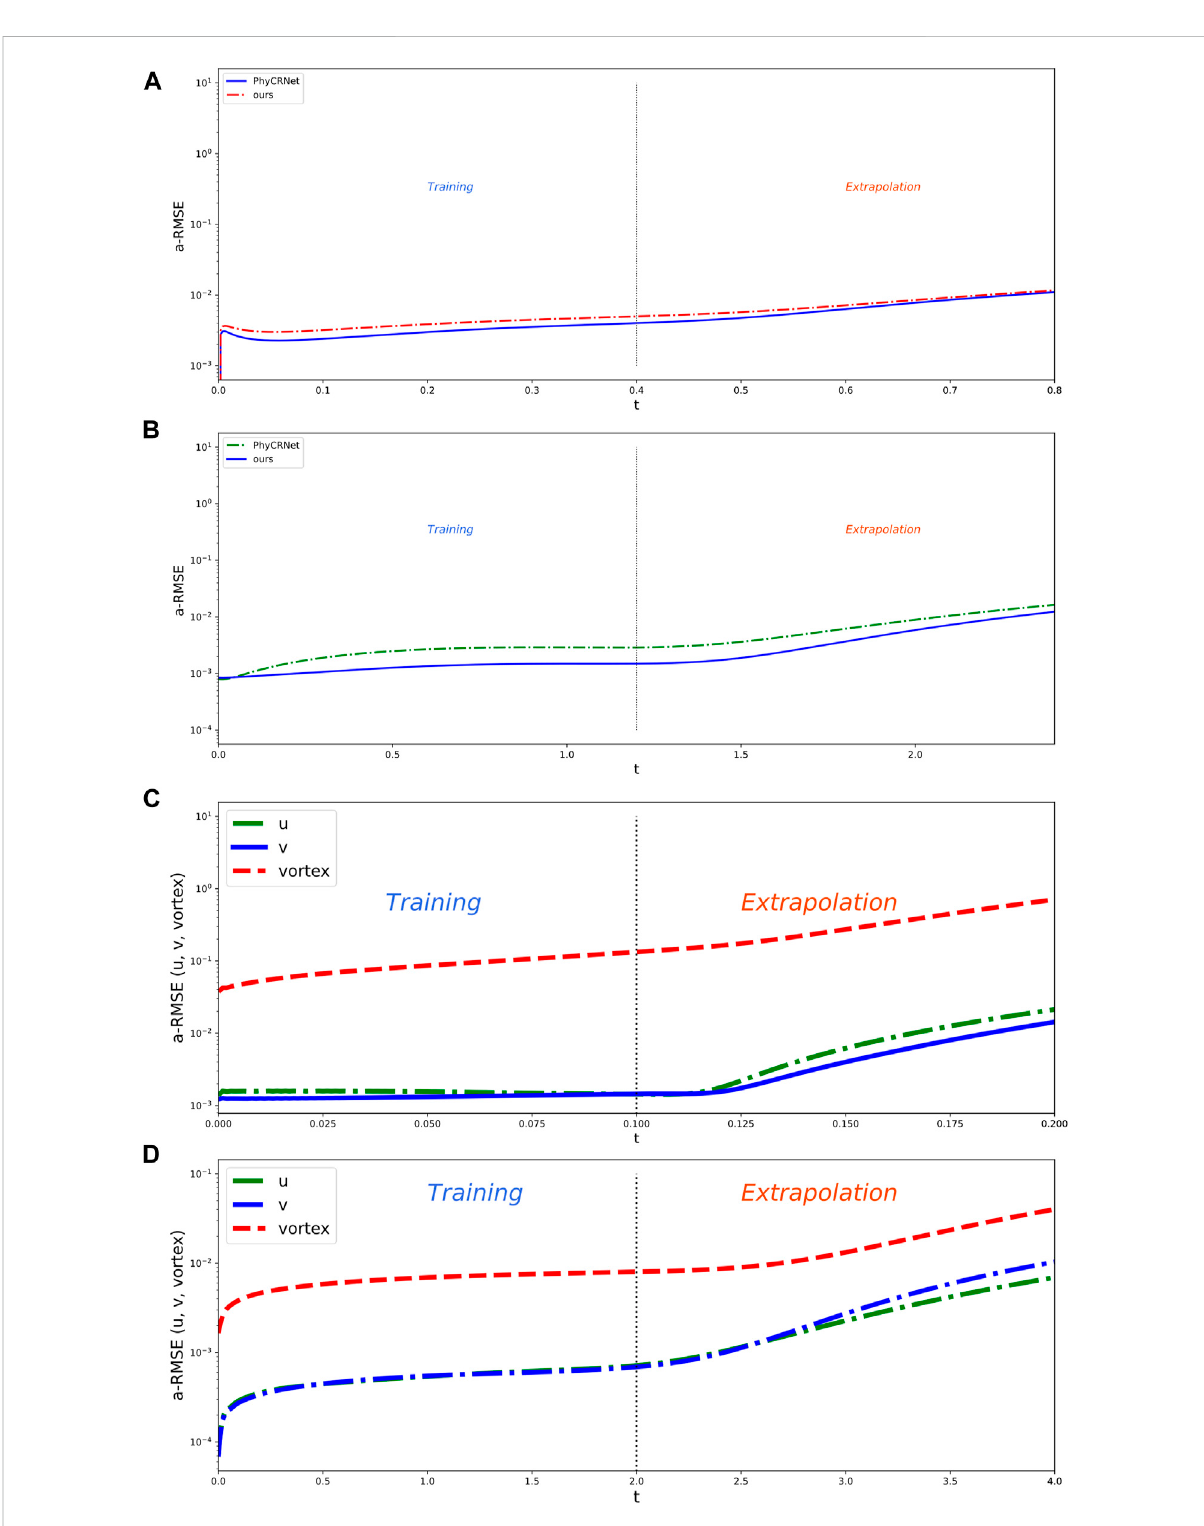
The a-RMSE of the four Equations. (A) 2D viscous Burger ’ s equations; (B) FitzHugh – Nagumo RD equations; (C) Vorticity equation; (D) 2D Navier-Stokes